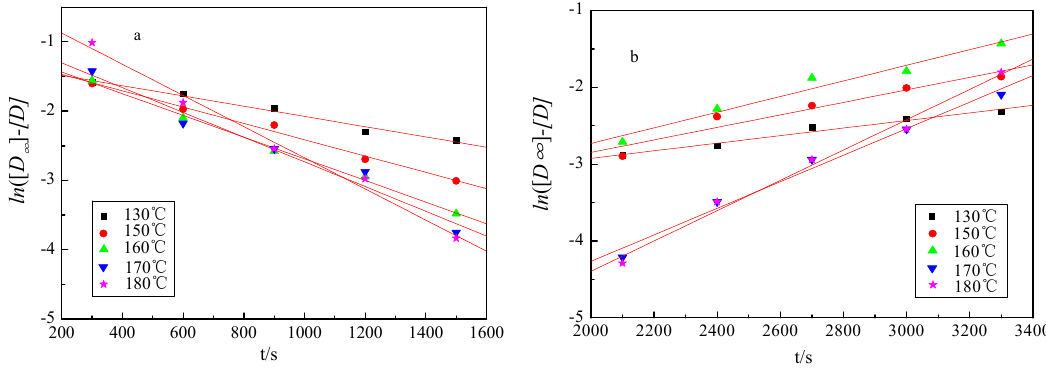
Figure 4. The linear fitting curve for the two-separate-stages kinetic model. ( a ) The first stage; ( b ) the second F ig 4: The linear fitting curve for the two-separate-stages kinetic model